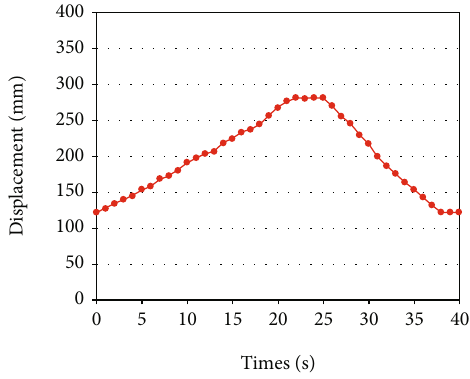
Figure 14: Multiple reciprocating motion.